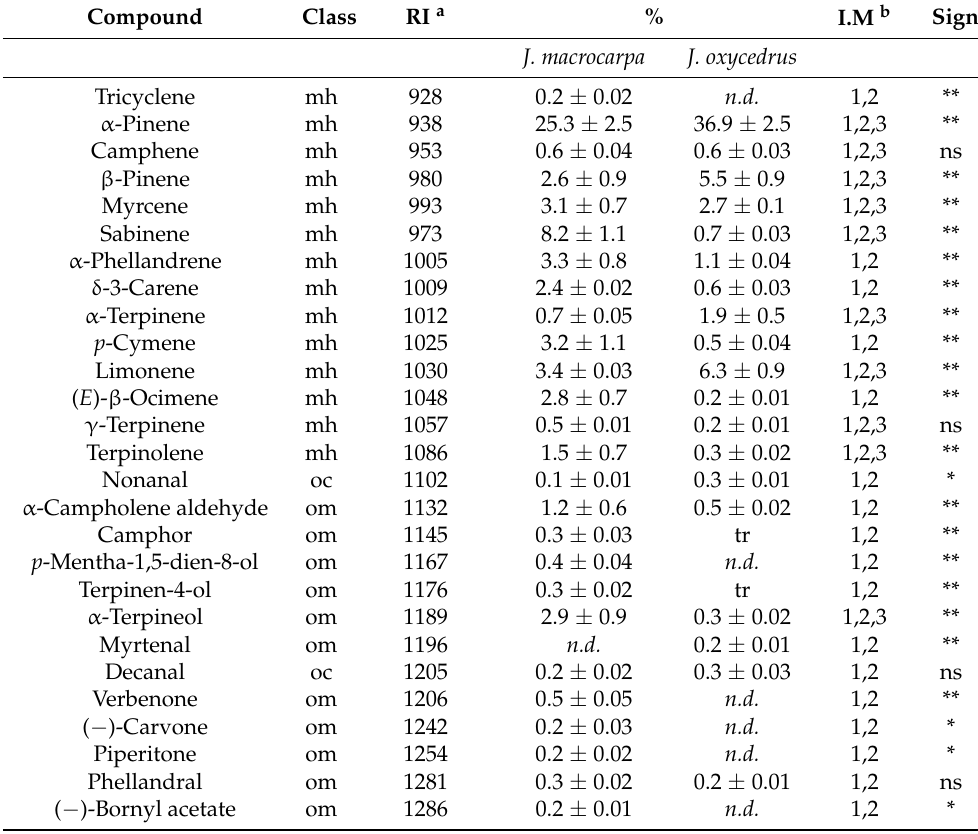
Table 1. The main identified constituents of J. macrocarpa and J. oxycedrus essential